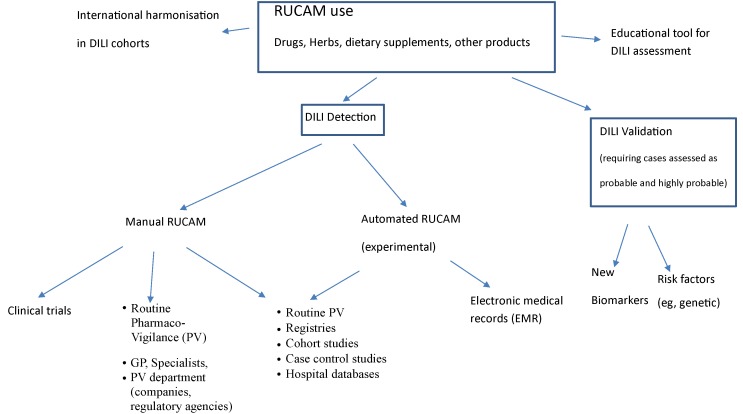
Current RUCAM use.